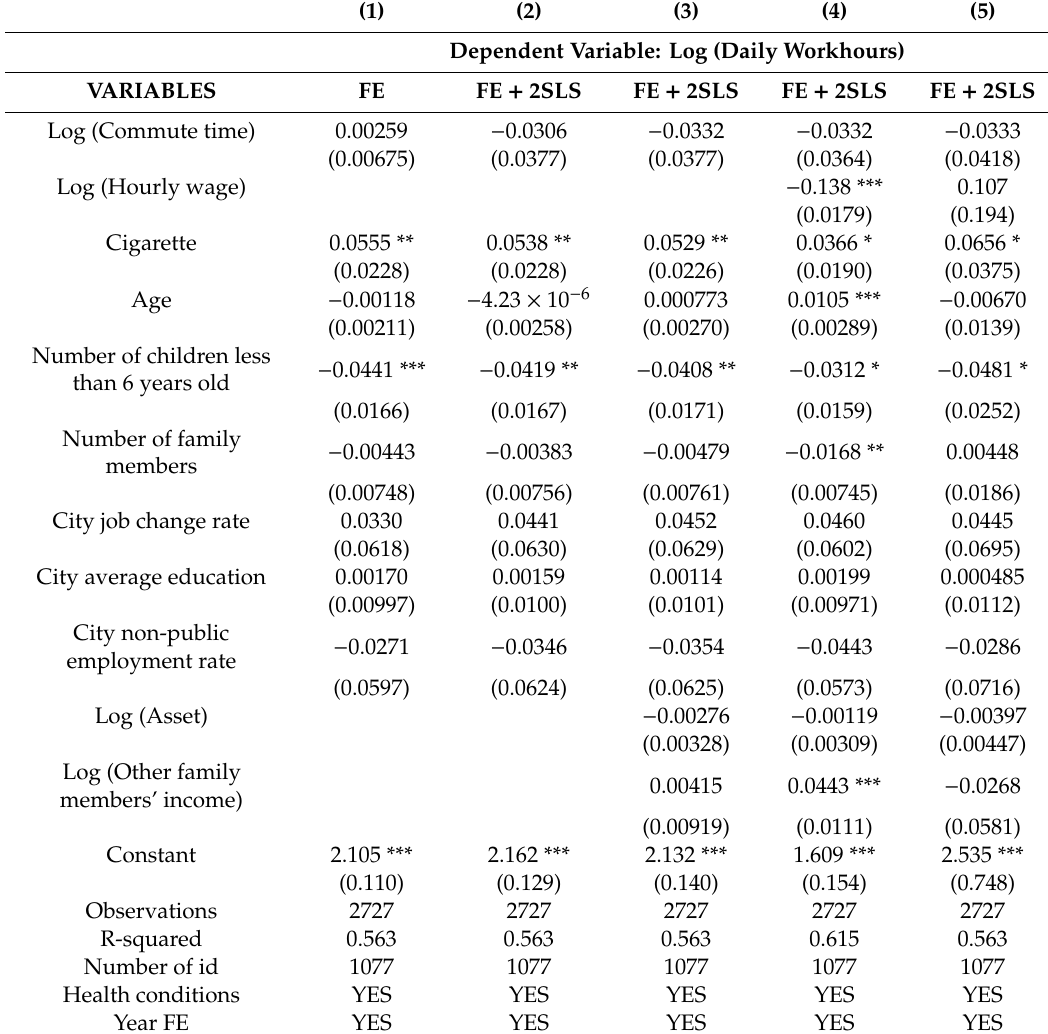
Table 4. E ff ect of commute time on labor supply—daily